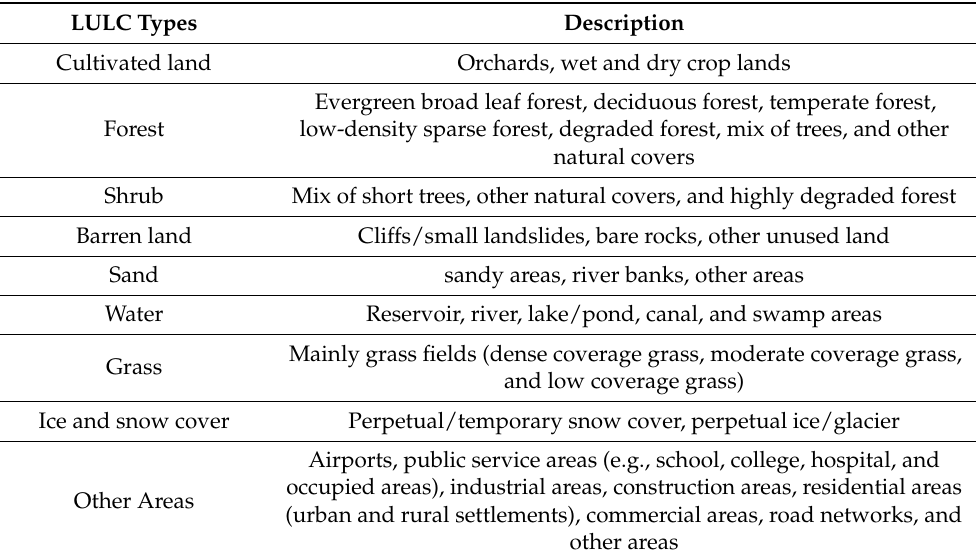
Table 2. LULC classification